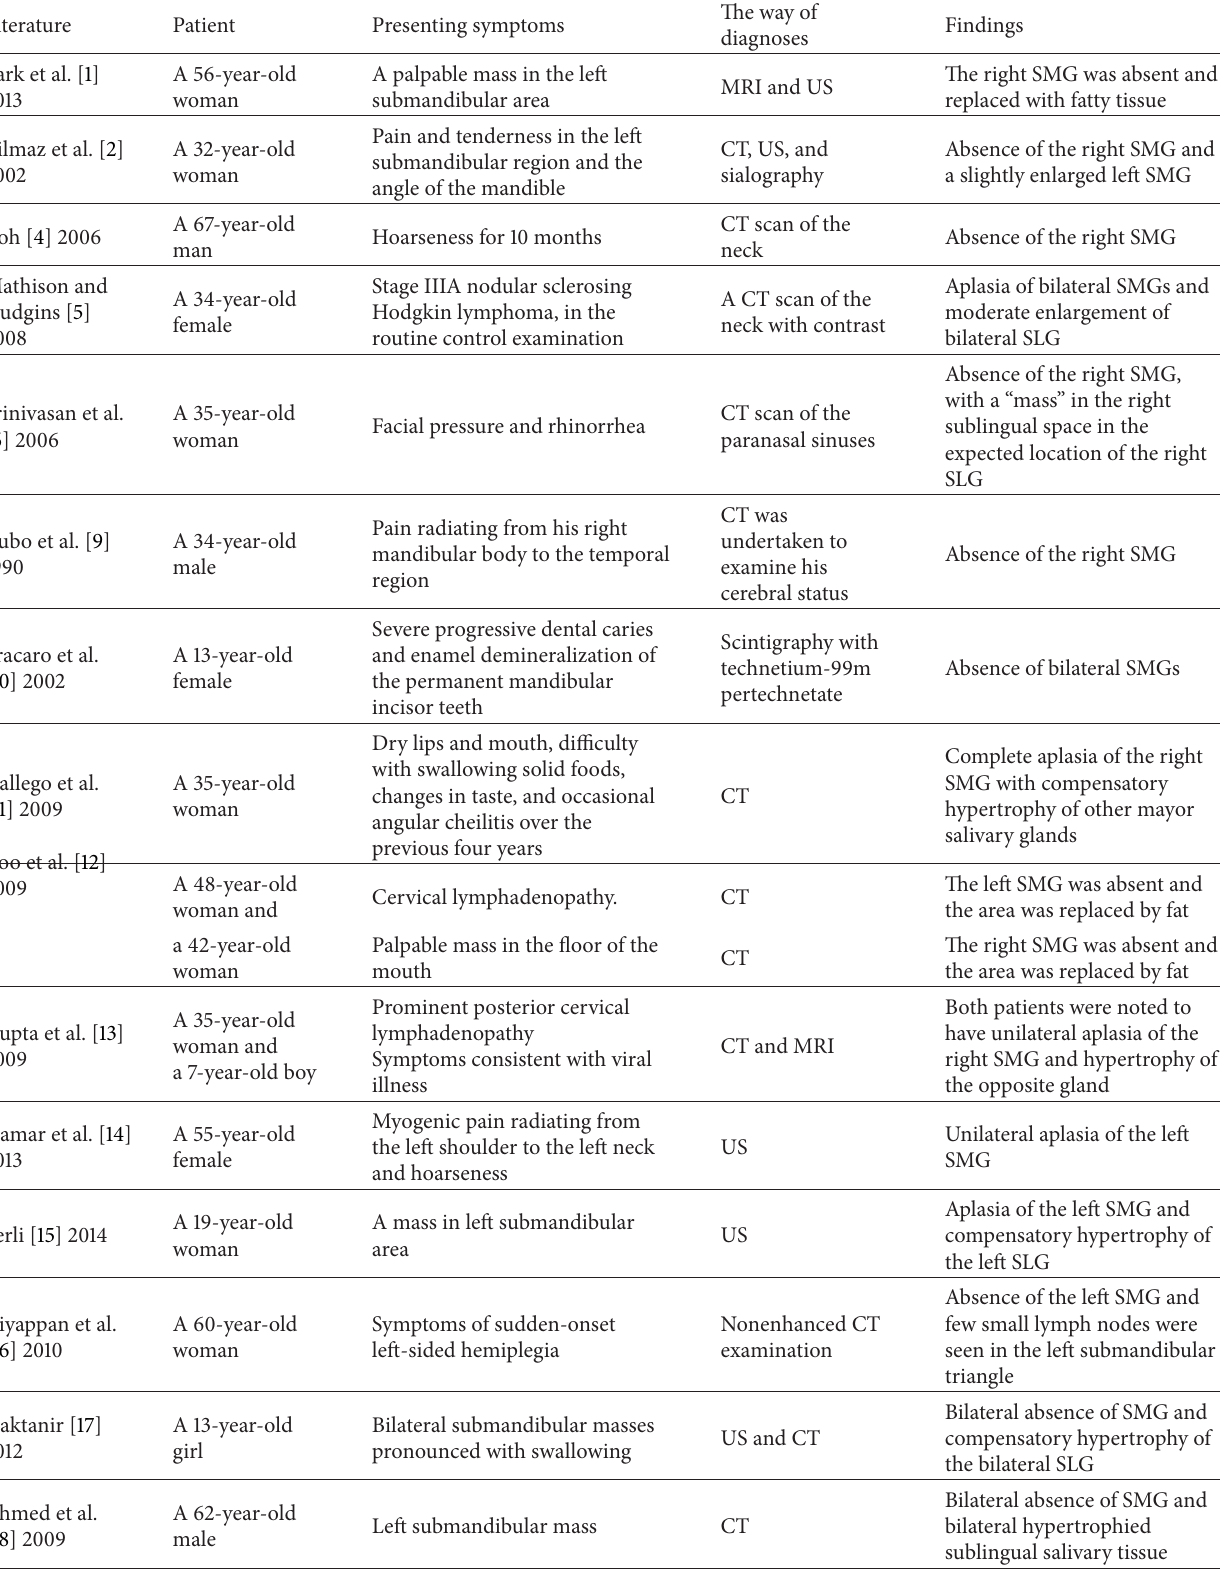
Table 1: A literature review of the case reports with absence of the submandibular